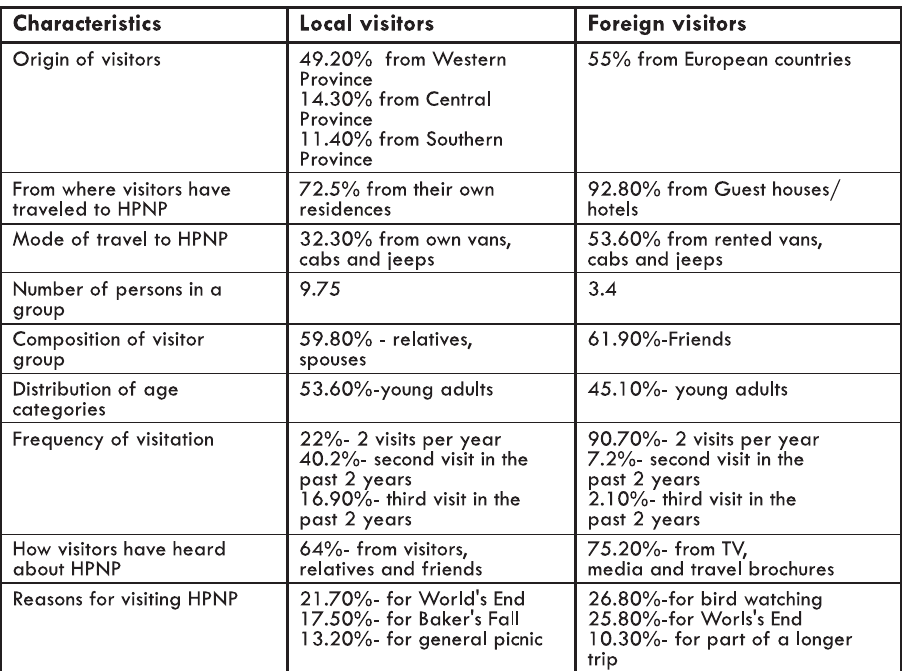
Table 1: Visitor characteristics at